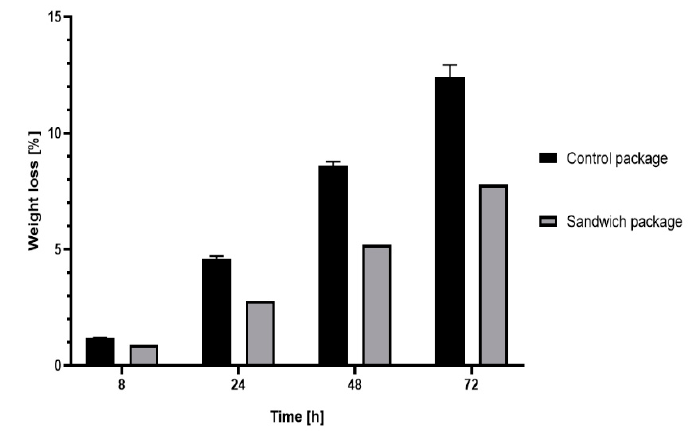
Figure 7. Weight loss of the bread after storage in paper and in the modified package.